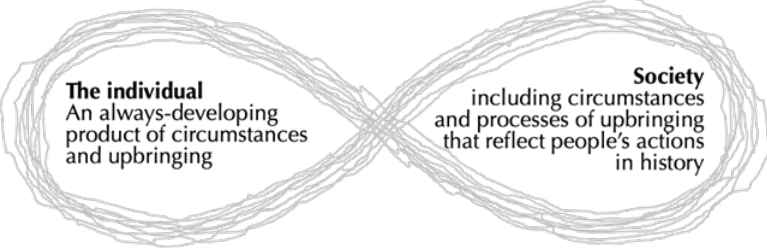
Figure 1. The dialectic of the individual and the social. Reproduced with permission from Kemmis (2022), p. 97.